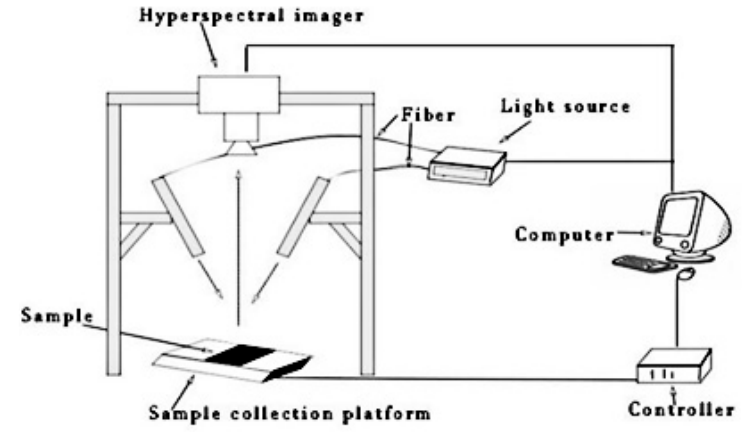
Figure 1. Hyperspectral imaging system.